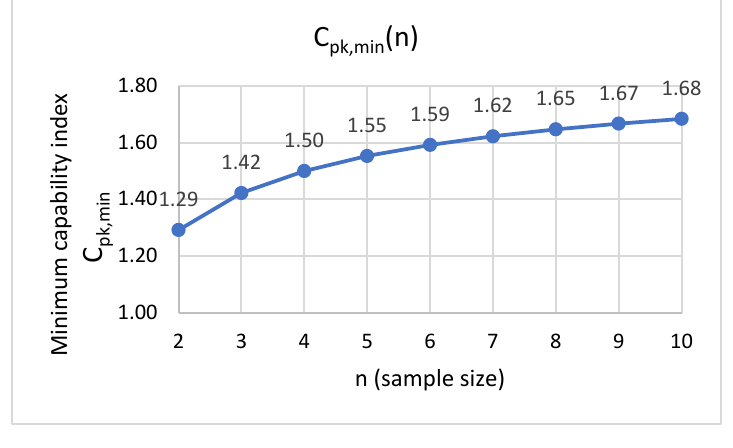
Figure 5. The dependence of the minimum capability index C pk on the sample volume n.